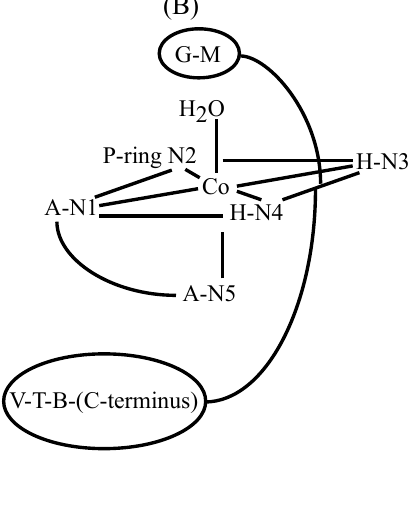
and -B as proposed by Lehmann et al . 2 2